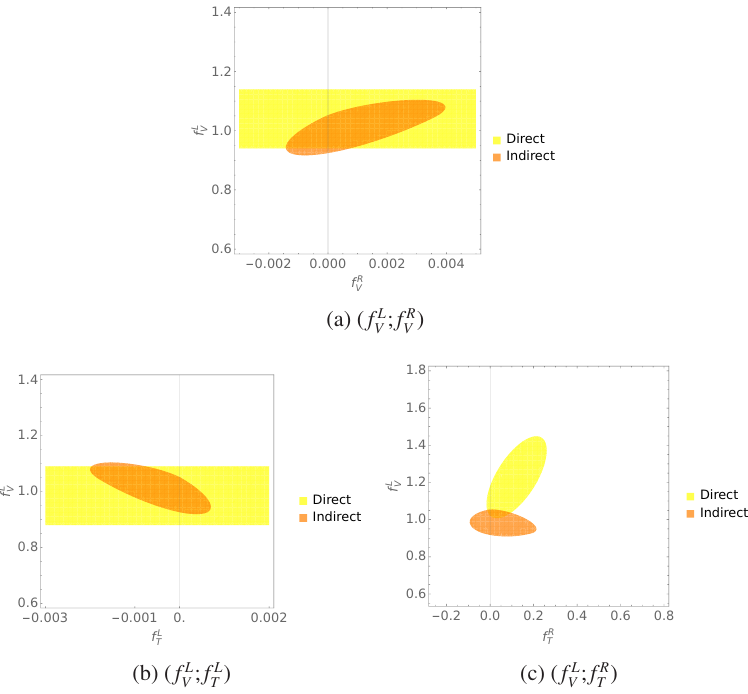
Figure 2: The images correspond to 95% C.L. allowed ( f i ; f j ) regions for three channels: ¯ B oscillations, B B X s γ , B X s (cid:30) + (cid:30) − («indirect»); and from the t-channel single top − → → quark production cross section («direct») from